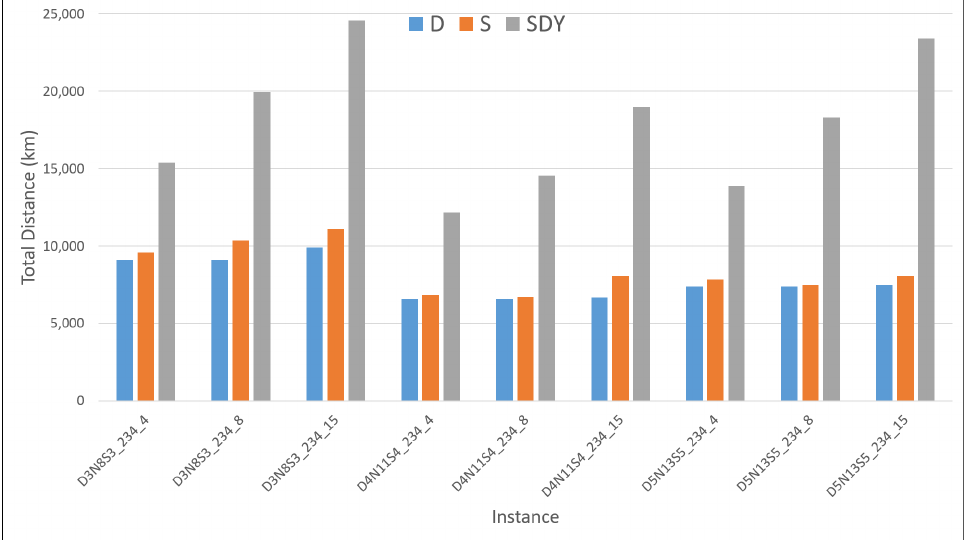
Figure A6. Total Distance Travelled for Maximum Road Capacity Setting ( 2,3,4 ) : Offline and Online Computation for all Instances based on Model